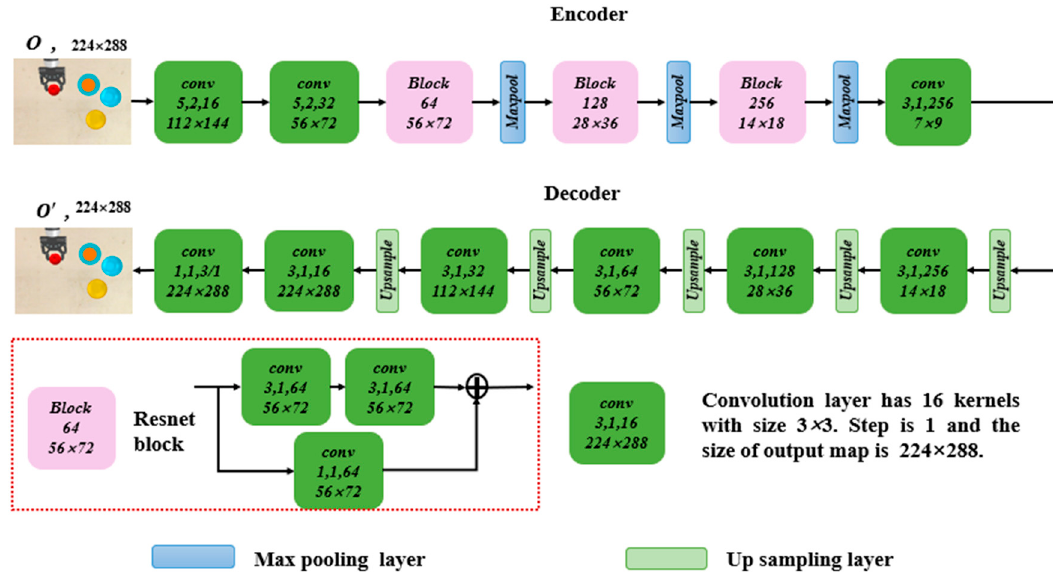
Figure 2. The detailed structure of autoencoder.